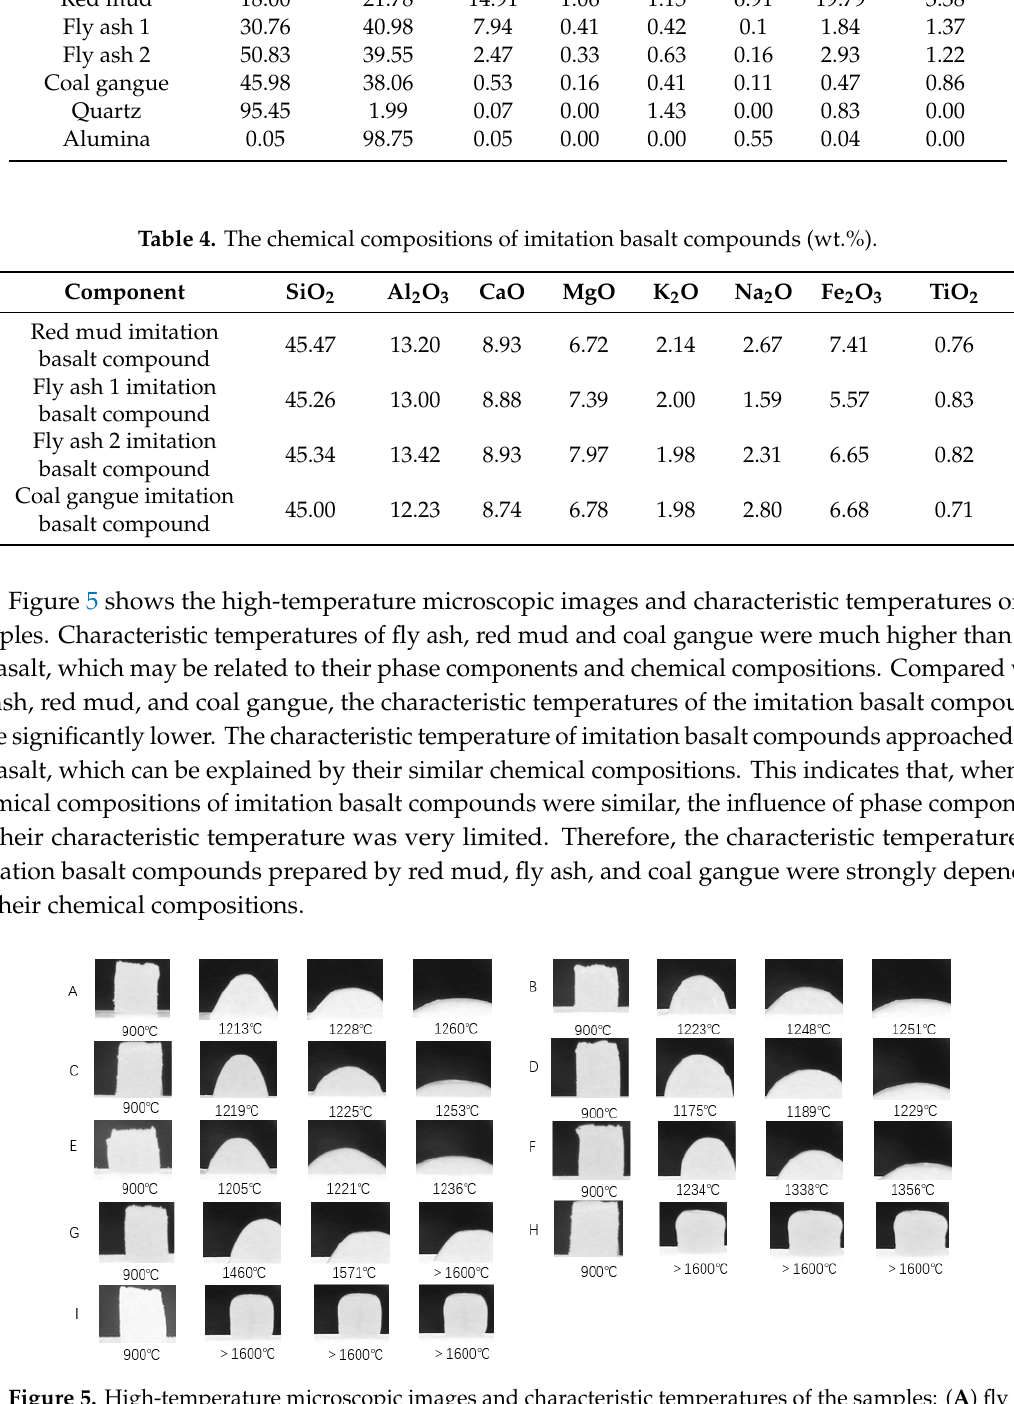
Table 3. The chemical compositions of samples (wt.%).